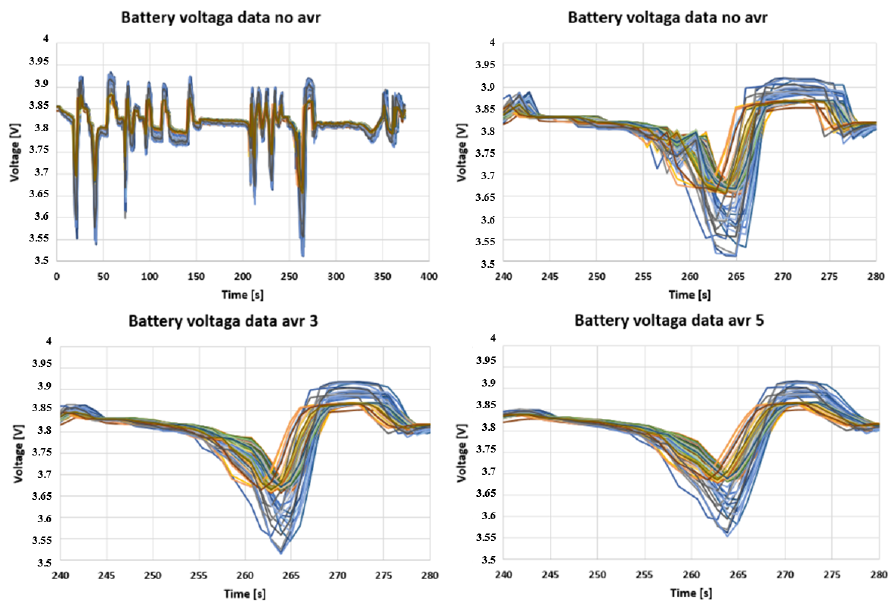
Figure 10. Different ways of averaging the voltage values of the measurements (the different color lines indicate the 88 battery cells).